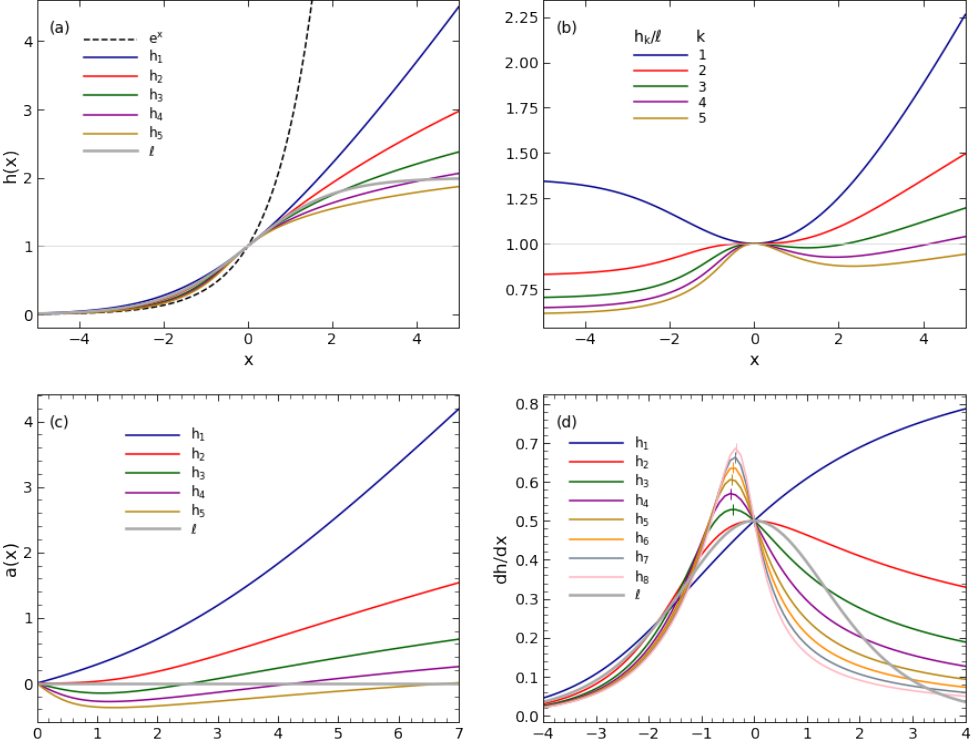
Figure 1. Mathematical hindering functions. ( a ) Plots of single-term hindering h k (Equation (12)) for various values of k , as labeled, and of the logistic (cid:96) (Equation (15)). A thin horizontal line at h = 1 marks the boundary between the unhindered ( x < 0, h < 1) and hindered ( x > 0, h > 1) domains. Also shown is the exponential e x in dashed line. ( b ) The ratio h k ( x ) / (cid:96) ( x ) . ( c ) The asymmetry measure a (Equation (19)) for h k and (cid:96) . ( d ) Time derivatives of h k and (cid:96) (Equation (20)). All pass through (cid:16) (cid:17) 0, 1 the point (see Equation (9)). Except for h 1 , every derivative has a peak, marked with a short 2 vertical